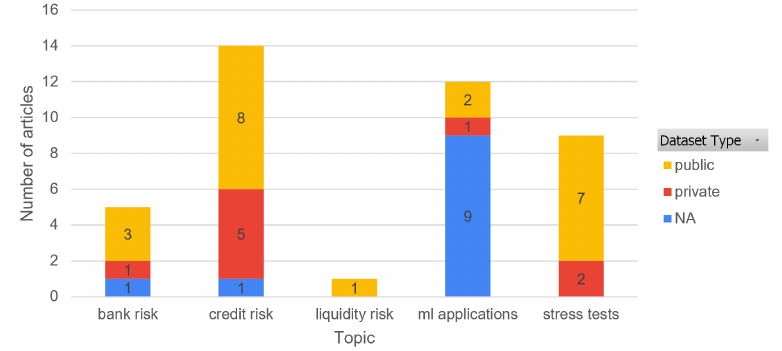
Figure 4. Dataset types by research topic ( NA —not